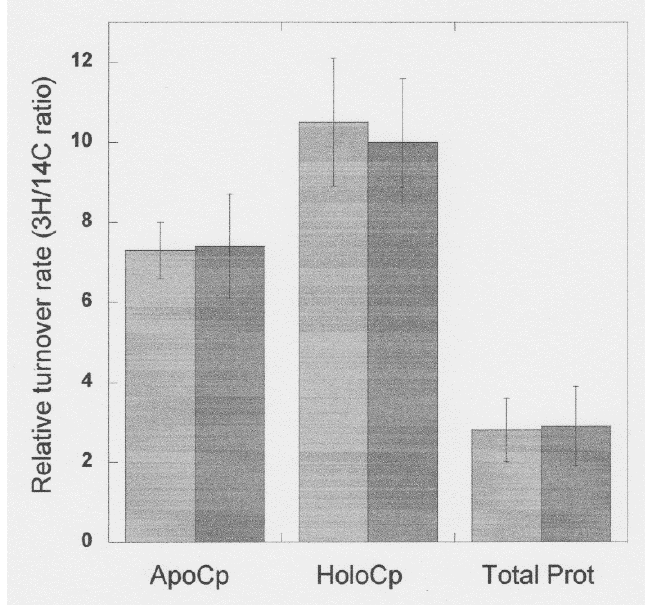
Figure 10. Relative rates of removal of apo and holo ceruloplasmin from the circulation, after synthesis in rats untreated and treated with estrogen, determined by double-labeling. Rats were injected with 14 C-leucine, followed by 3 H-leucine 17 h later, and euthanized 3 h later, following which their plasma ceruloplasmin was partially purified, separated in native PAGE tube gels (see Figure 4), and the radioactivity of both isotopes was determined in the apo and holo ceruloplasmin (Cp) gel bands, as well as in the total protein of blood plasma. Dark bars were for rats pretreated with 17 β‐ estradiol for 14 days; light bars control rats only treated with vehicle. Data are means ± SD for groups of 5–10 animals. * p > 0.05 for the effect of estradiol. Data are from Middle ‐ ton and Linder [28].